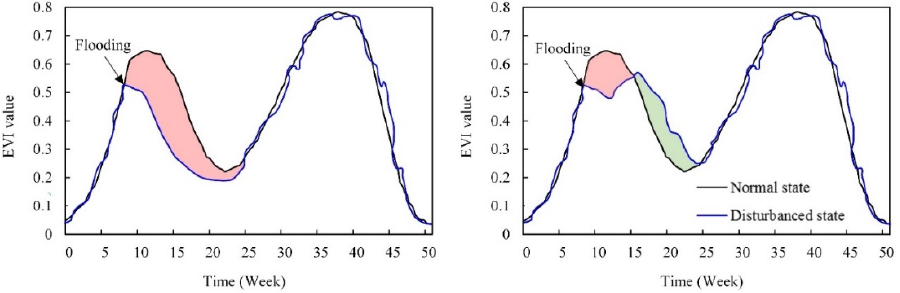
Figure 1. The conceptual model illustrating the effect of flood disturbance on crop production. The red area represents the effect of the disturbance of flood on crop growth, and the green area repre- sents the subsequent recovery of the crop.